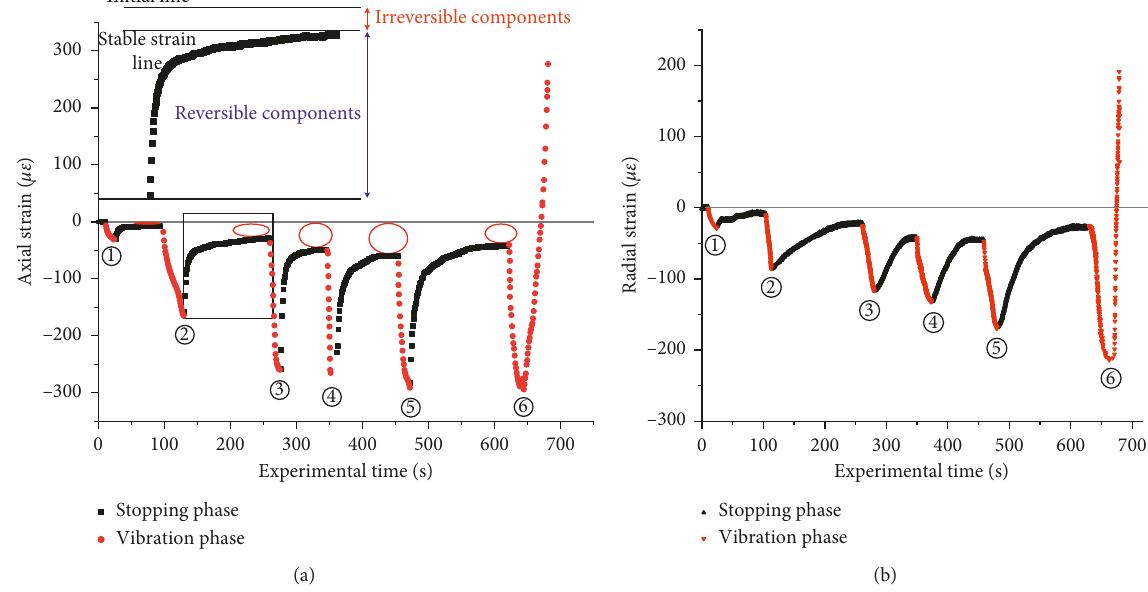
Figure 8: Strain of samples under the discontinuous ultrasonic vibration test. (a) Axial strain. (b) Radial strain.